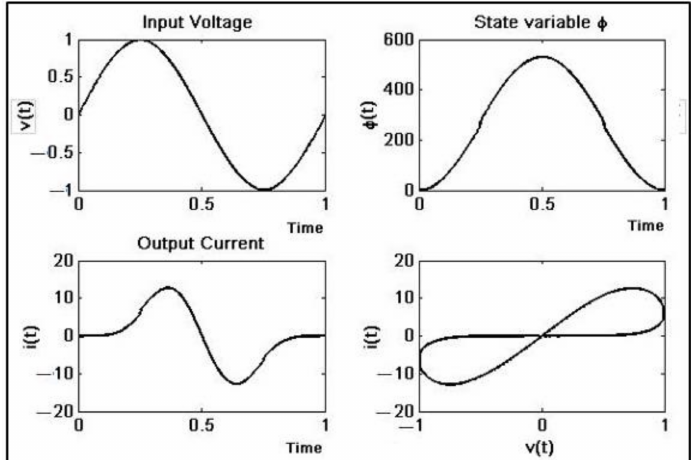
Figure 11. FPGA memristor emulator